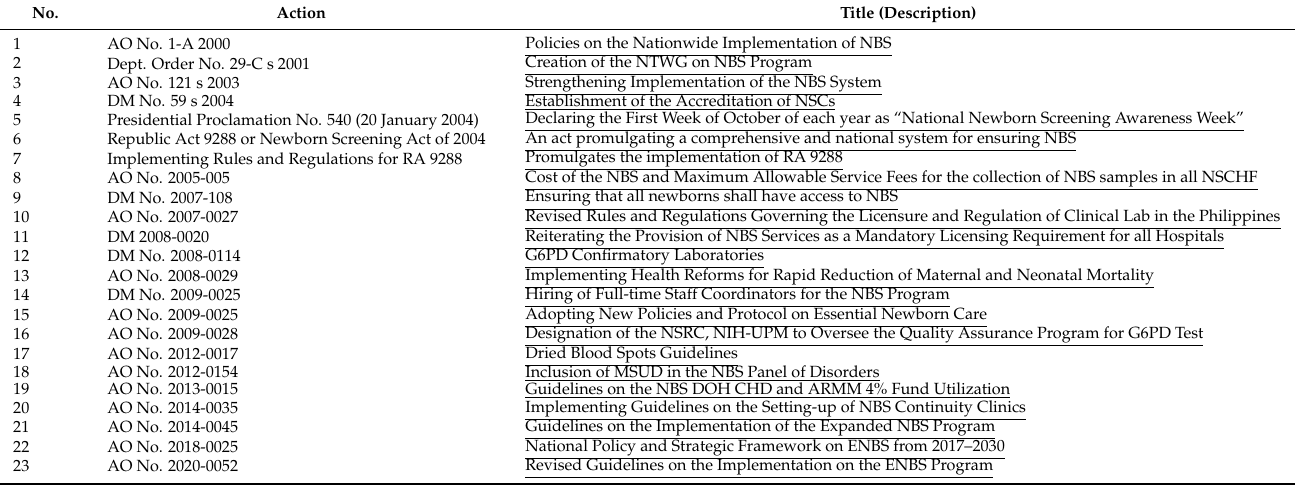
Figure 2. Timeline and screening coverage for various stages of implementation of NBS in the Philippines. National insurance coverage for ENBS was approved in 2018. Despite the COVID-19 pandemic, which began in early 2020, NBS coverage in 2020 exceeded 80% and ENBS was 79.4%. Abbreviations: CH = Congenital Hypothyroidism; CAH = Congenital Adrenal Hyperplasia; GAL = Galactosemia; HCY = Homocystinuria; PKU = Phenylketonuria; DOH = Department of Health; G6PDD = Glucose-6-Phosphate Dehydrogenase Deficiency; MSUD = Maple Syrup Urine Disease; ASA = Argininosuccinic Aciduria; ENBS = Expanded Newborn Bloodspot Screening. Table 3. Official actions contributing to the successful implementation of Philippine Newborn Screening Program and Expanded Newborn Screening (adapted from reference [48]).